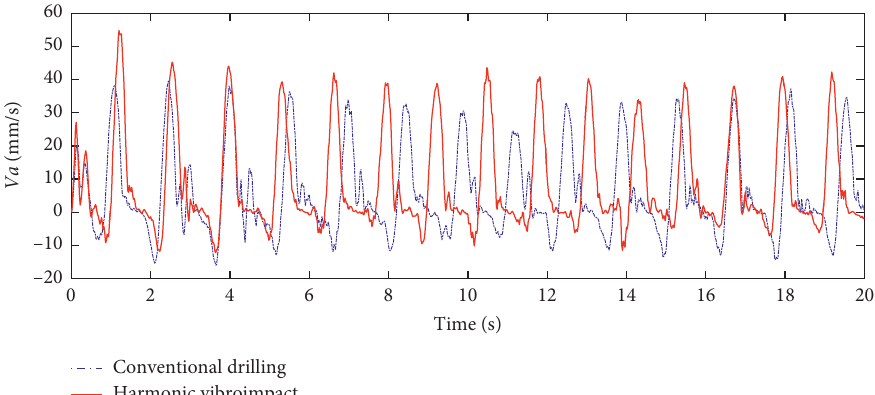
Figure 10: Time-history curves of ROP under different drilling conditions.